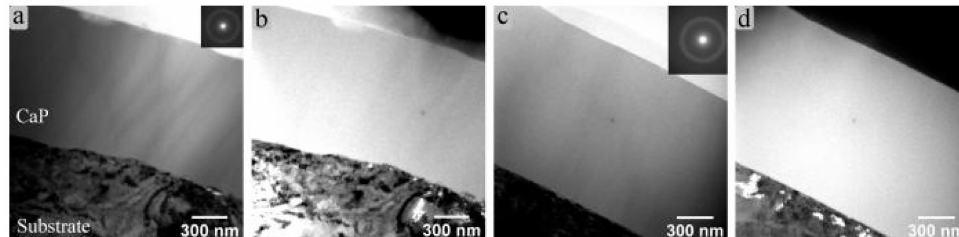
Figure 3. TEM images of the Zn-CaP coating cross-section in ( a ) bright-field and ( b ) dark-field and of the CaP coating cross-section obtained on Ti–6Al–7Nb substrate in ( c ) bright-field and ( d ) dark-field. Inserts show selected area electron diffractions gathered from corresponding coating